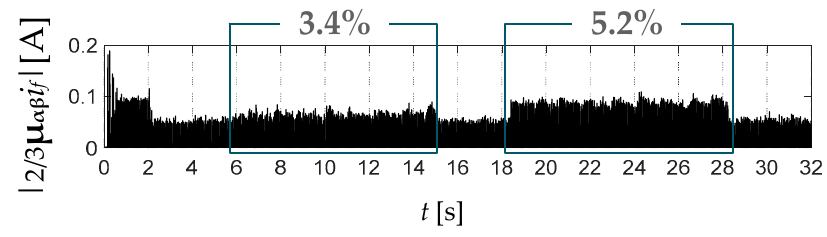
Figure 16. Modulus of the fault factor during ITSC (experimental results).